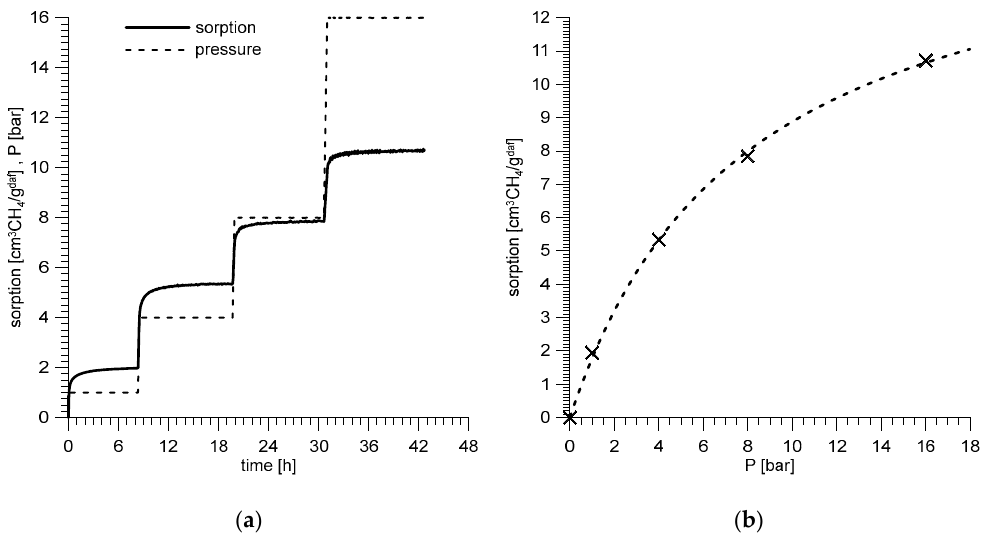
Figure 4. ( a ) Direct results of the sorption measurements—coal from the Zofiówka coal mine. ( b ) A sorption isotherm of the coal from the Zofiówka coal mine.